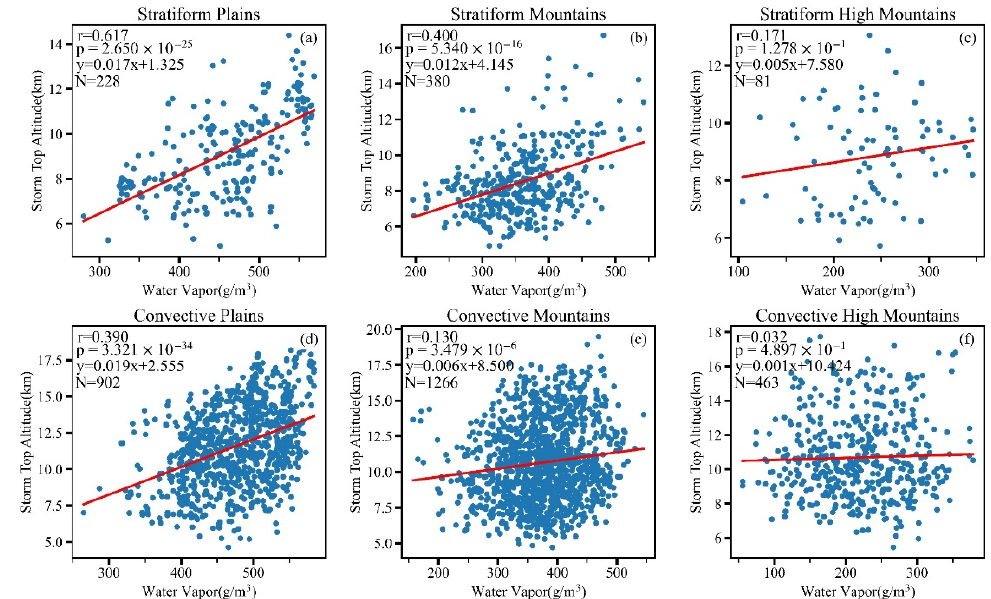
Figure 14. Scatter plots of water vapor and storm top altitude of two types of heavy precipitation over plains ( a , d ), mountains ( b , e ), and high mountains ( c , f ). r represents Pearson correlation coefficient, p represents significance level, y and red solid lines are the regression equation and N represents sample size.